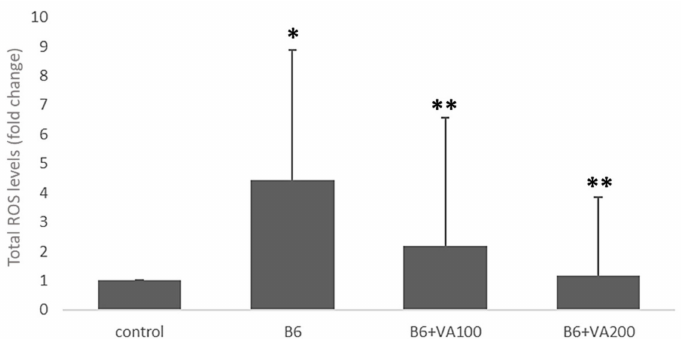
Figure 4. The effects of benomyl and benomyl accompanied by two concentrations of VA (100 and 200 µ M) on the total reactive oxygen species (ROS) levels of the cells. B6: exposure to 6 µ M benomyl; VA100: exposure to 100 µ M valerenic acid; VA200: exposure to 200 µ M valerenic acid (* statistically significant difference compared to the control; ** statistically significant difference compared to the B6 group).